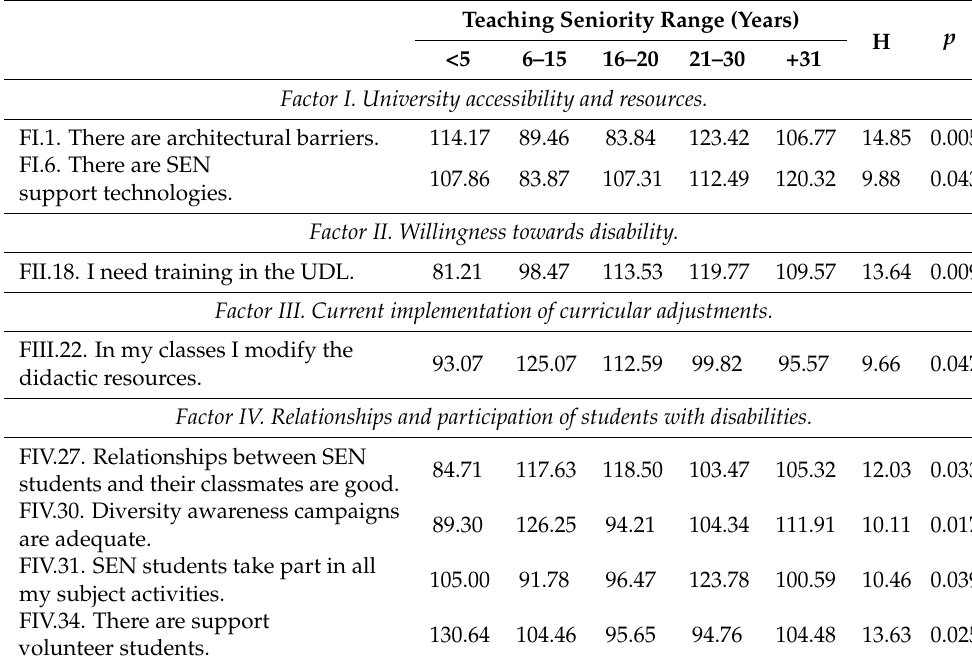
Table 9. Kruskal–Wallis analysis by sections of teaching